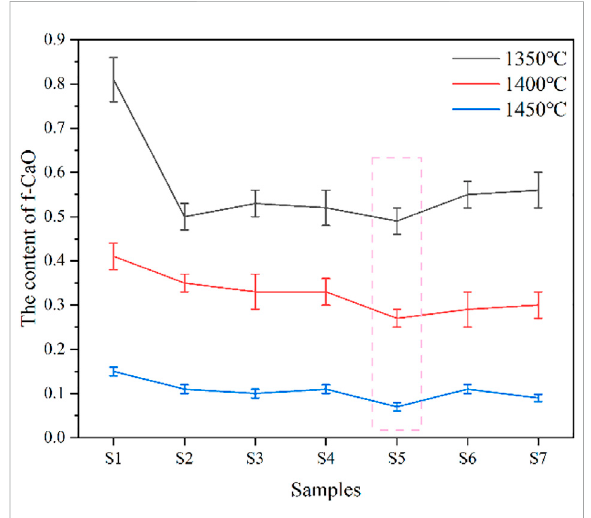
FIGURE 4 Test results of burnability of cementraw meal under different batching schemes.